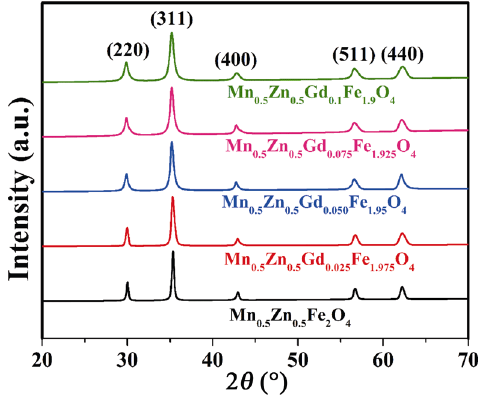
Fig. 2 XRD patterns for Mn 0.5 Zn 0.5 Gd x Fe 2 – x O 4 ( x = 0, 0.025, 0.05, 0.075, and 0.1) nanoparticles.